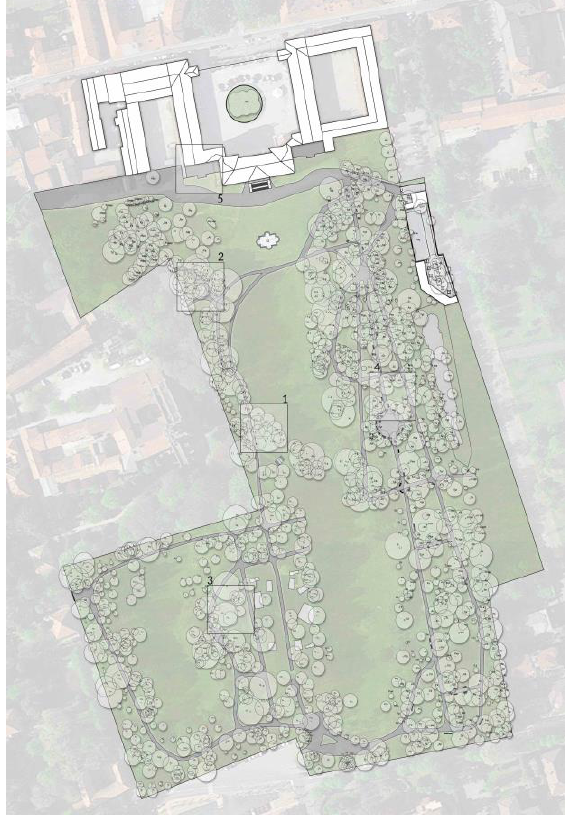
Figure 3. Botanic survey of Villa Cusani Traversi Tittoni historic public garden in Desio (Monza and Brianza Province).